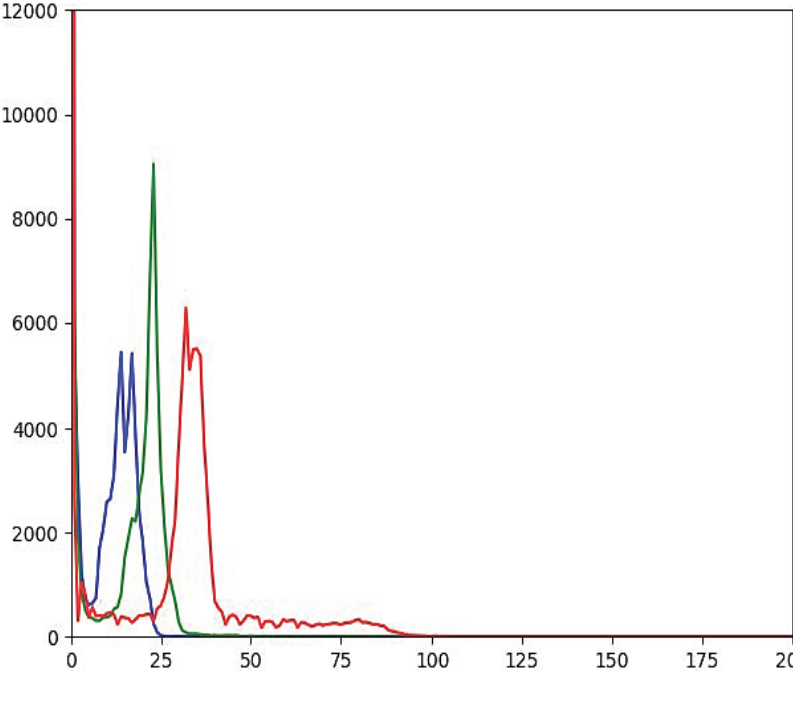
Figure 28. Histogram of the RGB graph for the image (see Figure